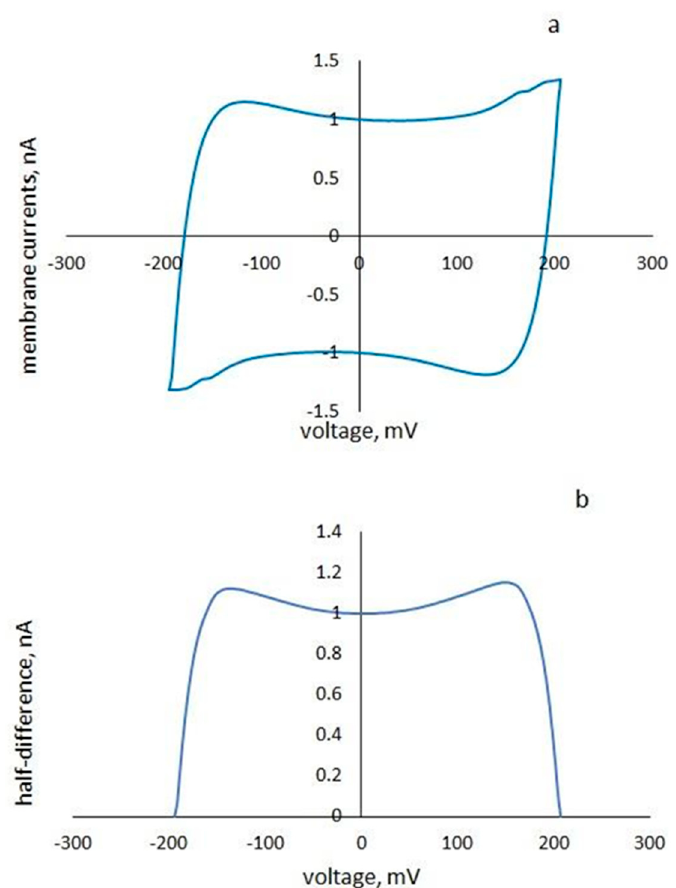
Figure 1. Cyclic current-voltage membrane characteristics ( a ) and the half-difference of the current responses to the upward and downward half-periods of the triangular voltage ( b ).